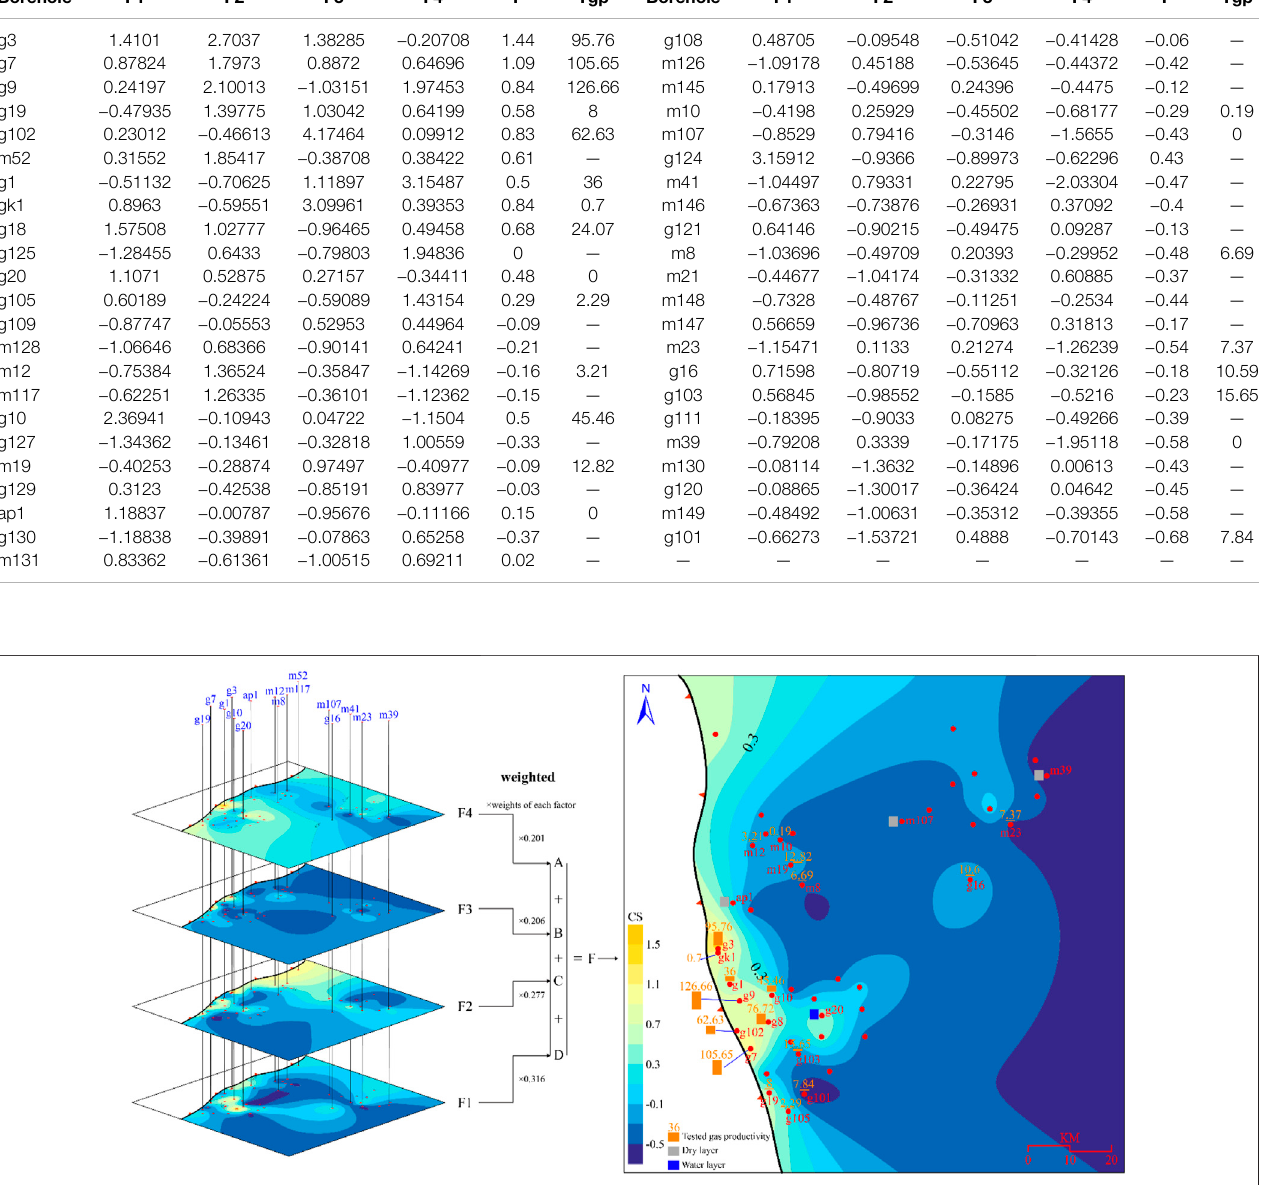
TABLE 4 | Factor scores, comprehensive score, and tested gas productivity (TGP) of each borehole. Borehole